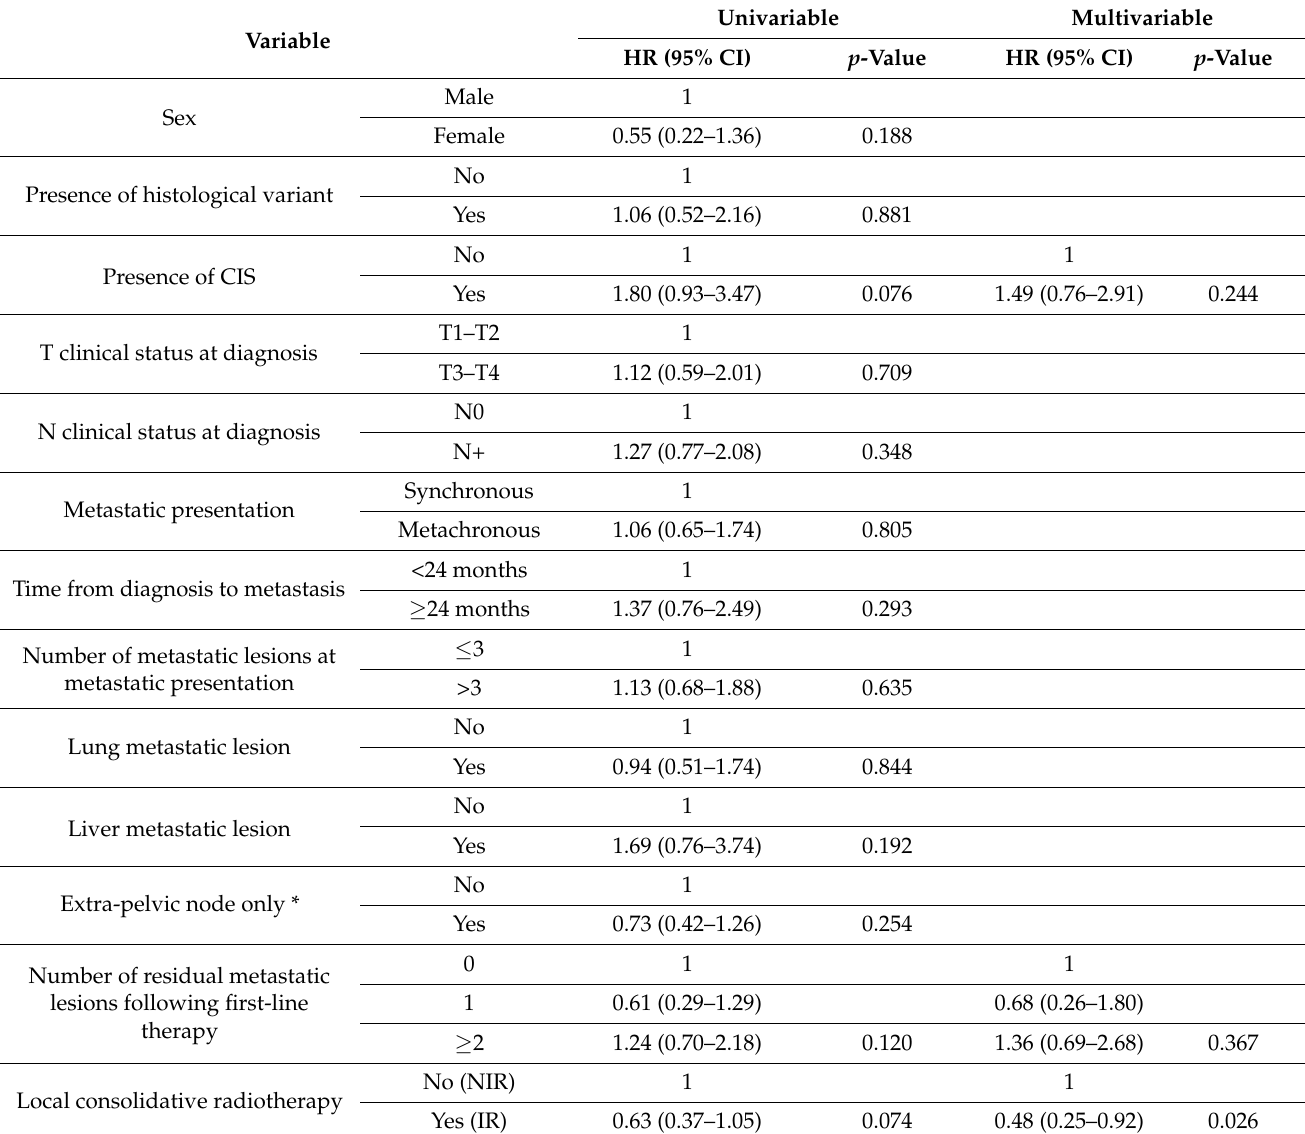
Table 4. Univariable and multivariable analysis for overall survival (landmark analysis at 6